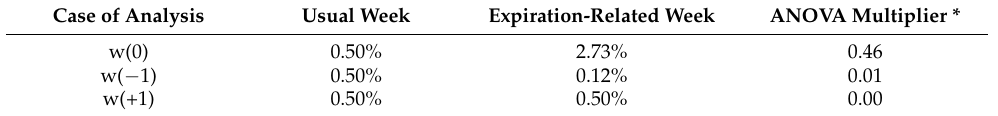
Table A7. Average returns for the usual weeks and expiration-related weeks.